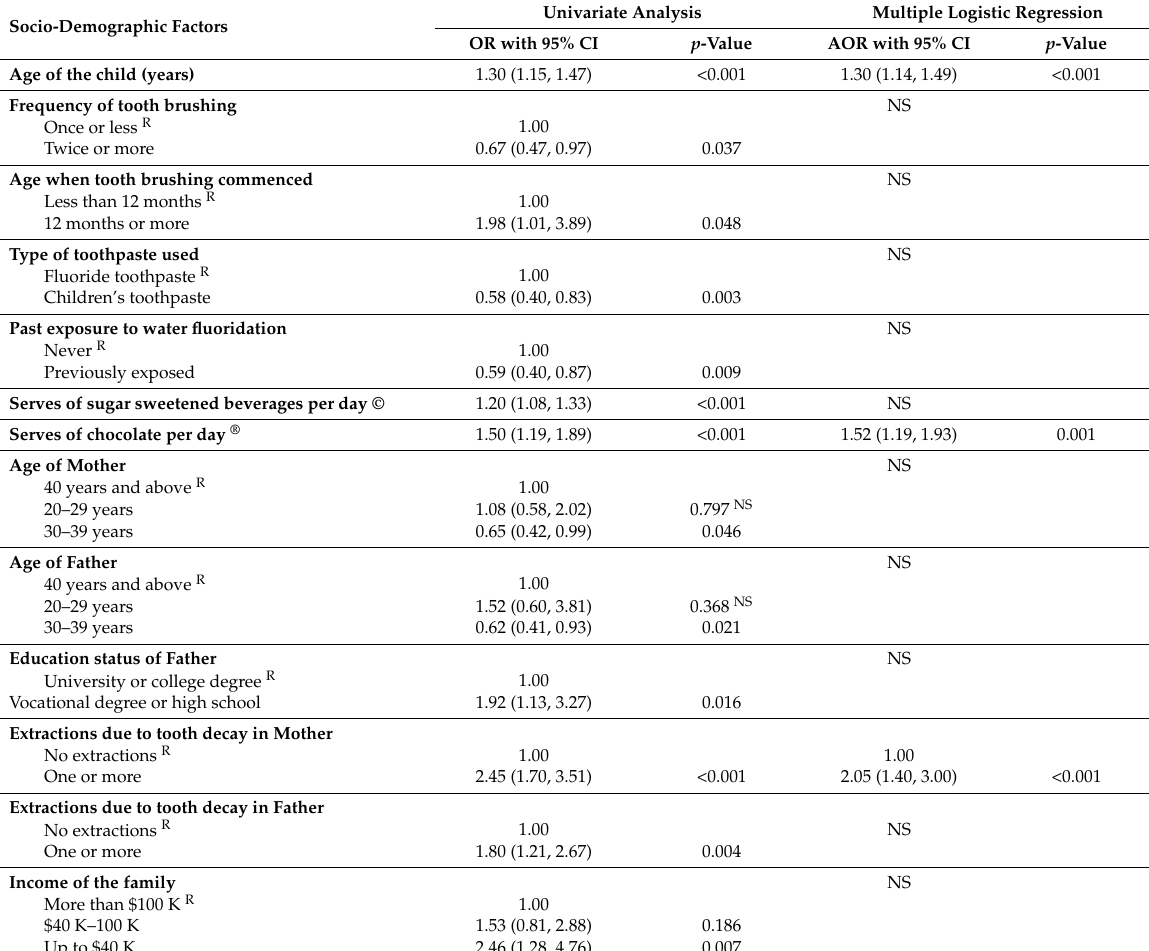
Table 2. Univariate and multivariate logistic regression analysis of primary dentition caries with non-imputed and imputed models. Socio-Demographic